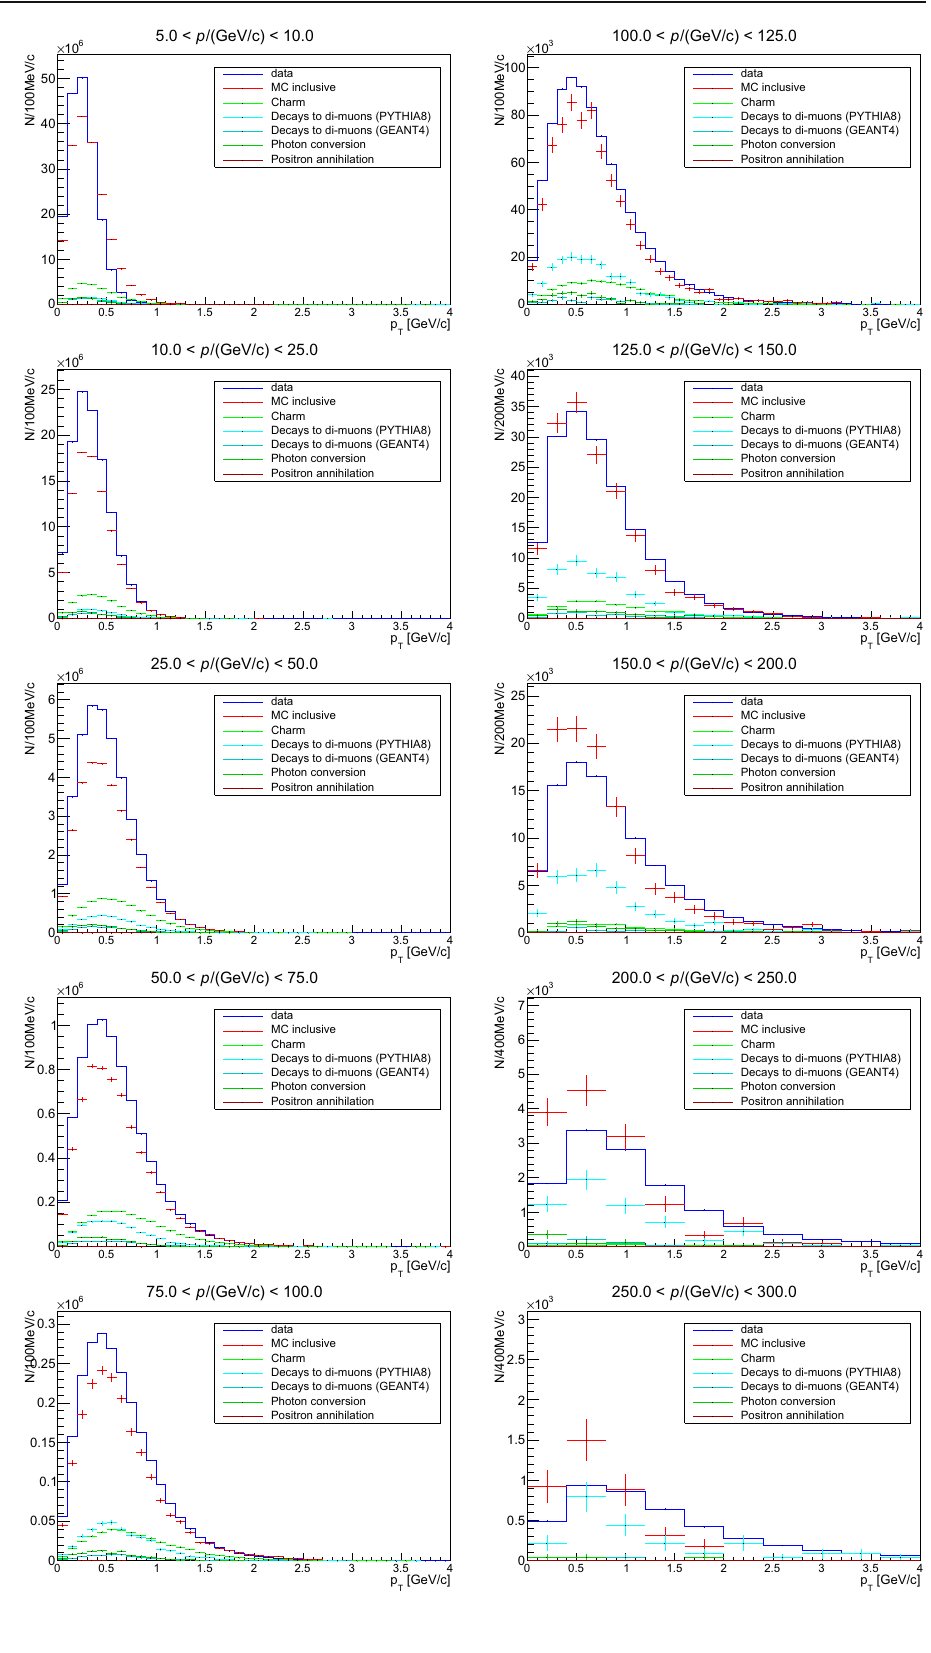
Fig. 7 p T distributions in slices of p for data and simulation. The units on the vertical axes are the number of tracks per bin, with the simulation normalised to the data